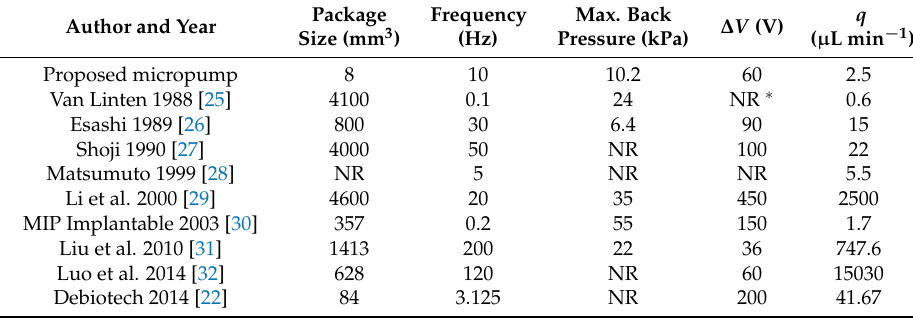
Table 4. A comparison of the proposed micropump with some previously fabricated devices. ( ∗ not